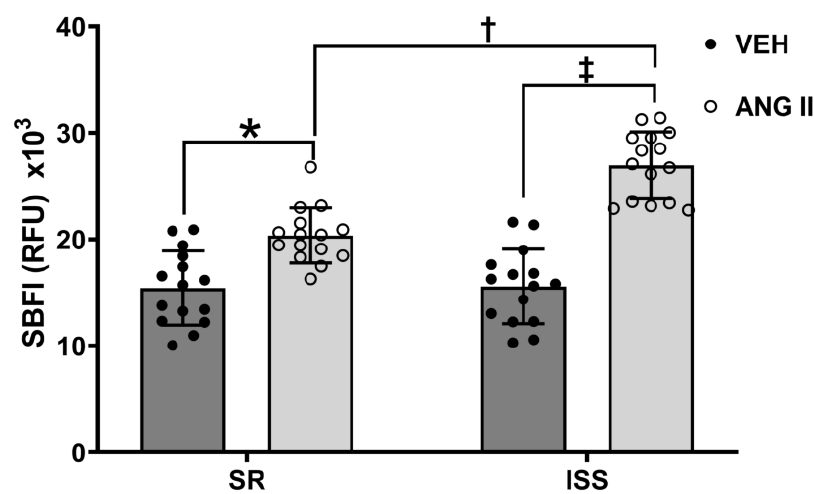
Figure 4. Sodium influx in SR and ISS cells under ANG II treatment. Ang II increases luminal sodium transport to a greater extent in uRPTCs from individuals with ISS than those from individuals with SR. uRPTCs, incubated in low salt concentration (90 mM Sodium as NaCl, osmolality adjusted to 290 mOsm/L with mannitol) for 2 h, loaded with sodium-sensitive ion indicator SBFI (Ex 340/Em 510), in the presence of ouabain to inhibit basolateral sodium exit, were studied with and without 10 nmol/L Ang II. There is a robust increase in sodium influx with Ang II stimulation in uRPTCs from both SR (15426 ± 900 RFU SR vehicle vs. 20,357 ± 667 RFU SR Ang II, n = 15, * p < 0.01) and ISS (15571 ± 904 RFU ISS vehicle vs. 26,942 ± 815 RFU ISS Ang II, n = 15, one-way ANOVA, Holm-Sidak test, ‡ p < 0.001) individuals. However, the Ang II-mediated increase in sodium influx is greater in individuals with ISS than individuals with SR (20357 ± 667 RFU SR Ang II vs. 26,942 ± 815 RFU ISS Ang II, n = 15, one-way ANOVA, Holm-Sidak test, † p < 0.001). ISS = inverse salt-sensitive; SR = salt-resistant. in uRPTCs from individuals with SR or ISS, we decreased D 2 R expression with D 2 R siRNA or overexpressed D 2 R and measured D 2 -like receptor binding by live-96-well fluorometry, using fluorescent spiperone, a D 2 -like receptor antagonist with high affinities to the members of the D 2 -like receptor family, D 2 R = D 4 R = D 3 R, [67,68]. In uRPTCs treated with control siRNA, spiperone binding was lesser in individuals with ISS than those with SR (36.9% ± 2.6% reduction in ISS control siRNA vs. SR control siRNA, n = 5, † p < 0.01) (Figure 5A), confirming the results using the extracellular epitope-specific D 2 R antibody (Figure 2). Spiperone binding in SR uRPTCs was reduced by DRD2 siRNA (37.1% ± 2.0% reduction in SR DRD2 siRNA vs. SR control, n = 5, * p < 0.01). Spiperone binding in ISS uRPTCs was reduced by DRD2 siRNA (42.7% ± 6.0% reduction in ISS DRD2 siRNA vs. ISS control, n = 5, * p < 0.01). The percent reduction in spiperone binding was not different between the SR and ISS uRPTCs. D 2 R overexpression increased spiperone binding in SR RPTCs (36.7% ± 7.9% increase over SR control siRNA ( n = 5, ‡ p < 0.01). D 2 R overexpression also increased spiperone binding in ISS uRPTCs (22.5% ± 4.8% increase over SR control siRNA ( n = 5, ‡ p < 0.01). The percent increase in spiperone binding in D 2 R overexpression in uRPTCs was not different between individuals with SR or ISS (Figure 5A). These results suggest that the spiperone binding assay is specific and sensitive enough to measure endogenous and exogenous D 2 R expression in uRPTCs, and not affected by SS, ISS or